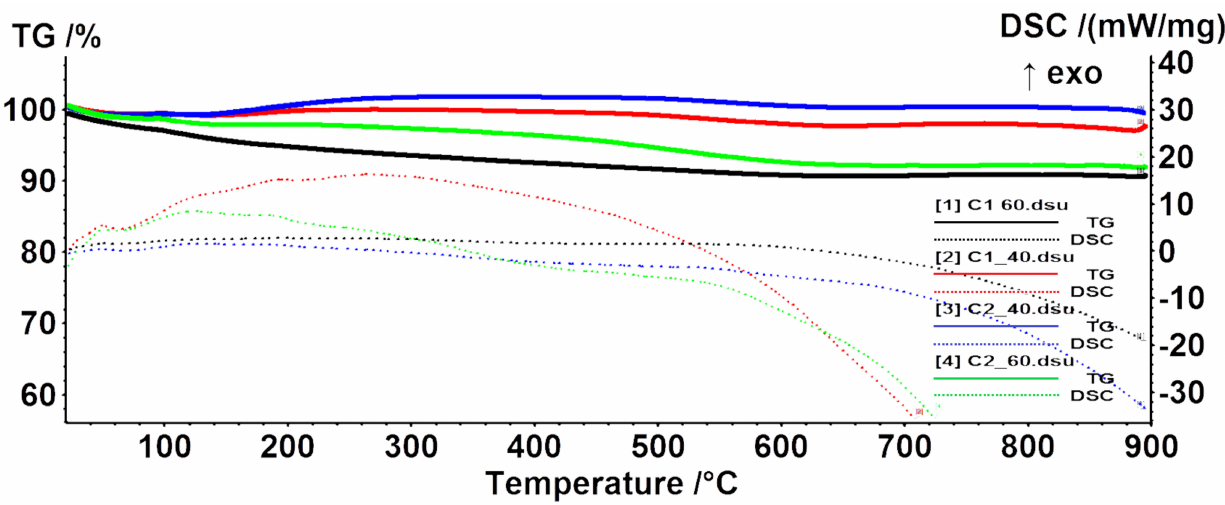
Figure 9. DSC-TG graphs for the synthesized